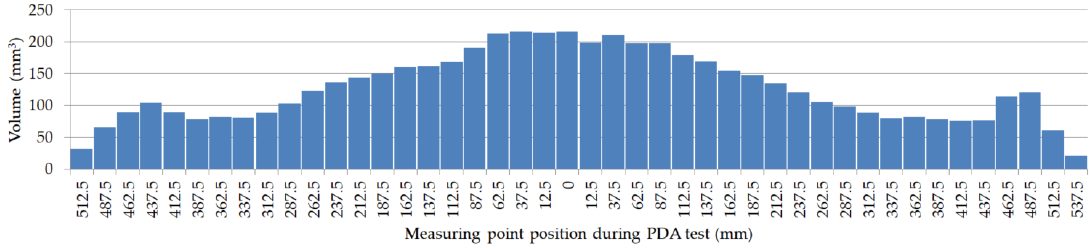
Figure 10. Liquid volume distribution determined on the basis of D30 diameters obtained in 2D-PDA analysis of the size and number of drops for nozzle number 2.